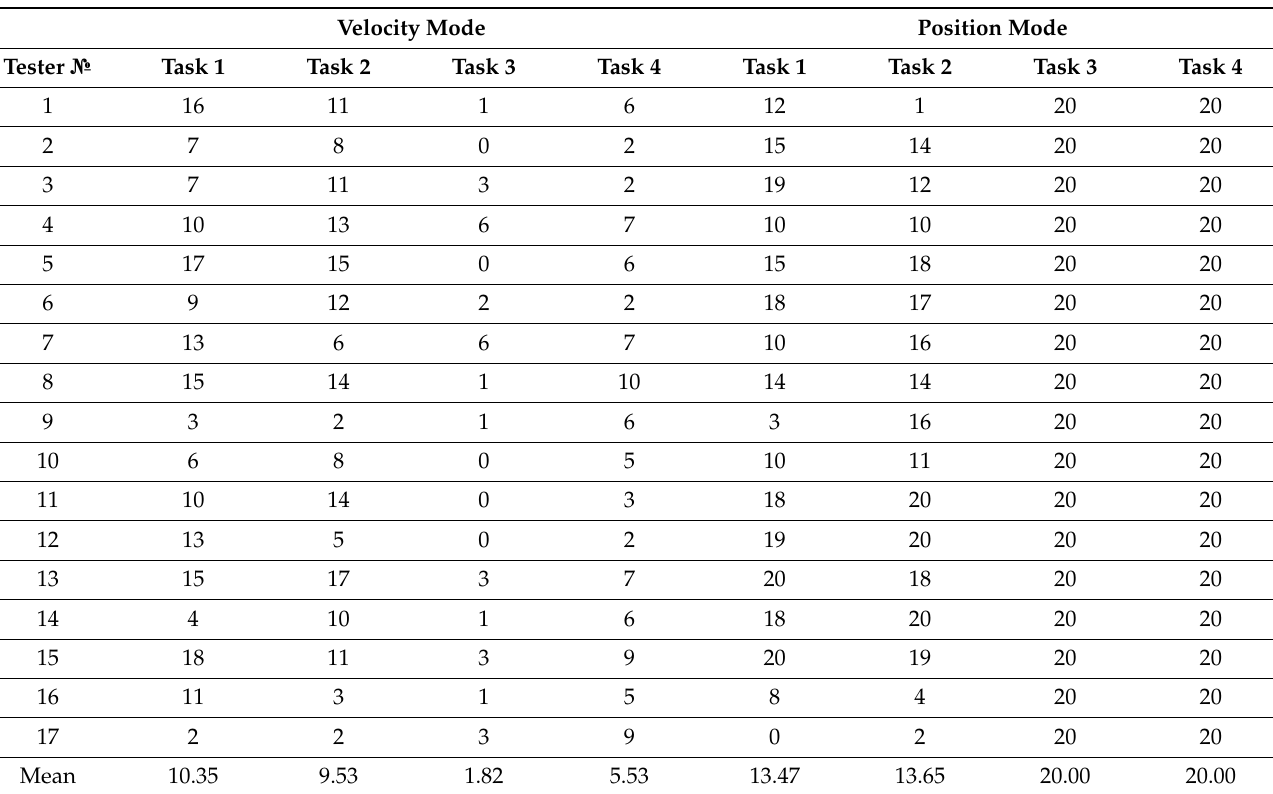
Table A1. Grades taken from NASA TLX forms for the active 2R spherical mechanism-based joint